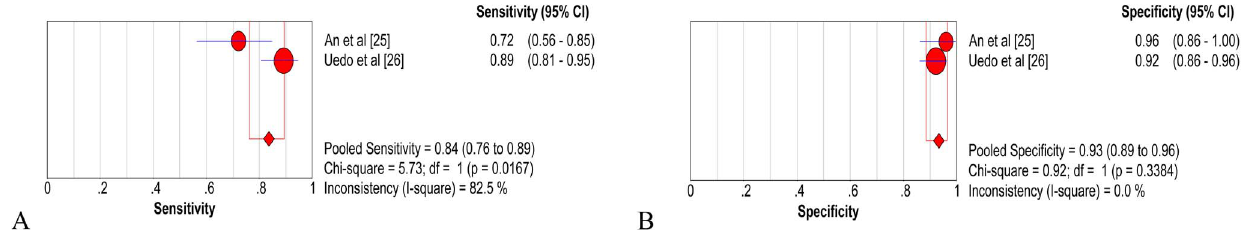
Figure 5. Gastric intestinal metaplasia (GIM), per-lesion analysis of diagnostic performance of magnification narrow band imaging (NBI-ME). A. Pooled sensitivity for NBI-ME to differentiate GIM; B. Pooled specificity for NBI-ME to differentiate GIM; C. The summary receiver operating characteristic (SROC) cure for diagnosis by NBI-ME. CI, confidence interval; df, degrees of freedom; AUC, area under curve; SE, standard error.